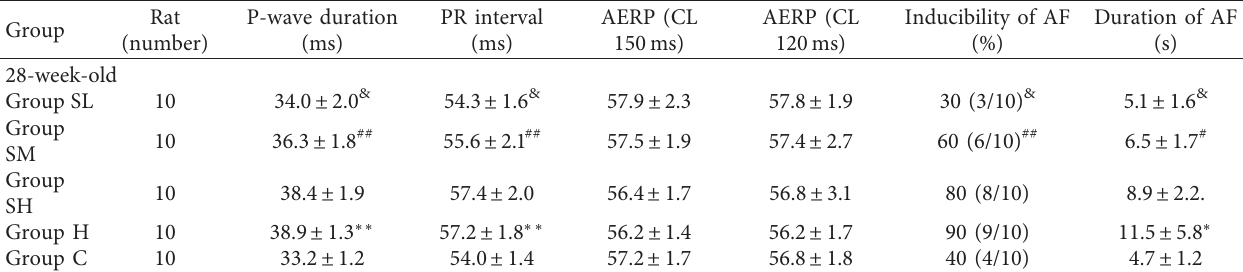
Table 4: Electrophysiological test results (M ± SD) (unit: ms).